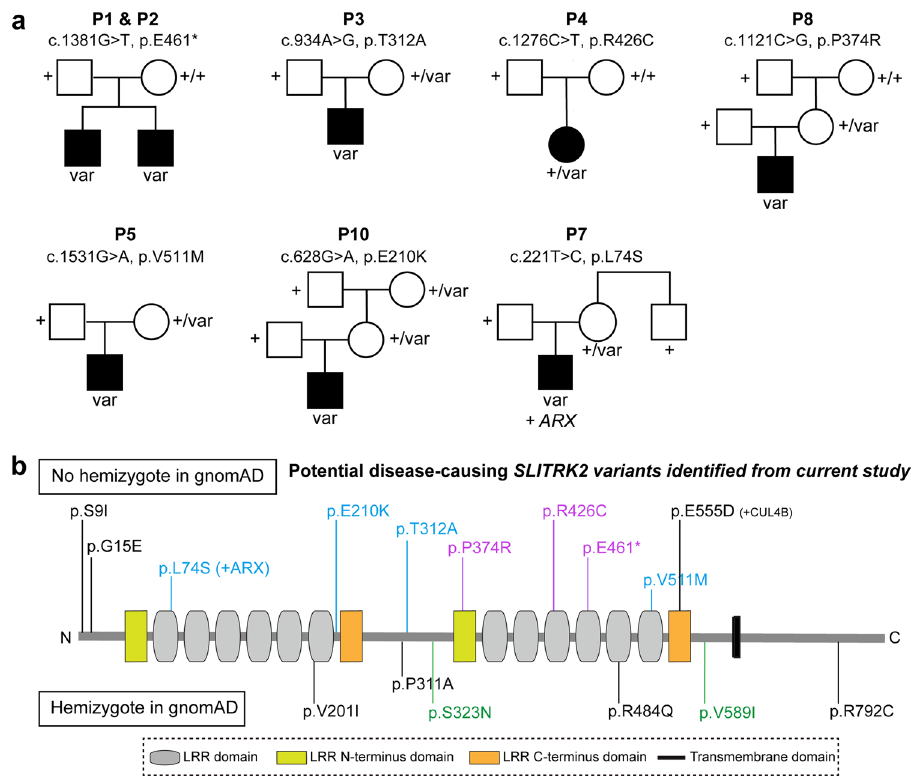
Fig. 1 Identi fi cation of SLITRK2 variants in individuals with NDD. a Pedigree of families with rare SLITRK2 variants. b Representation of the SLITRK2 protein, including the different variants identi fi ed in individuals with NDD and not previously reported in the hemizygous state in the gnomAD database (Purple, variants occurring de novo in the proband or his mother; blue, variants inherited from unaffected mothers without additional information; green, variants identi fi ed in gnomAD in at least two hemizygous